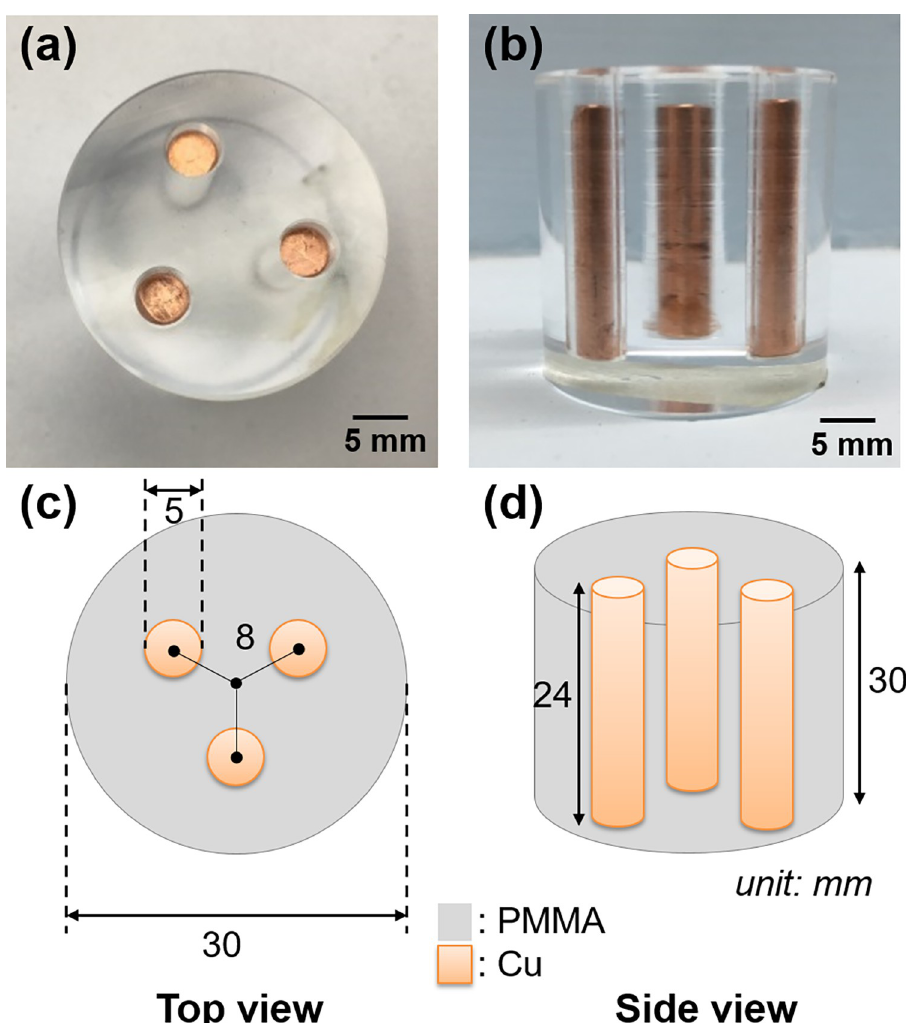
Fig 7. Metal artifacts evaluation (MAE) phantom in the experiments. (a) Top view of the phantom. (b) Side view of the phantom. (c) Schematic of the cylinder diameters and positions in the phantom. (d) Schematic of the cylinder heights in the